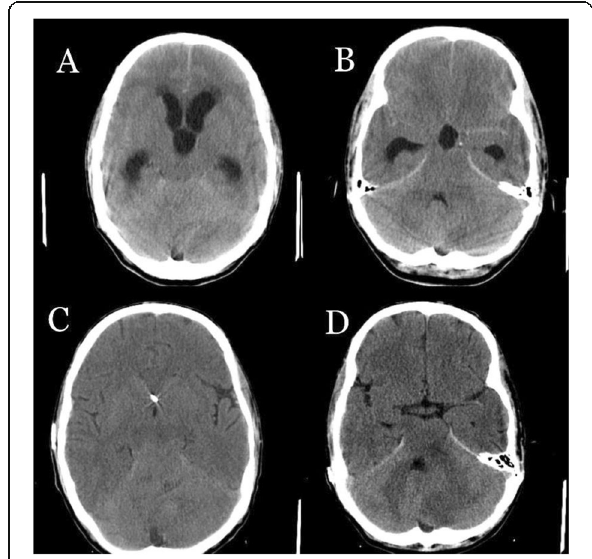
Fig. 2 a , b Initial CT scans showed a posterior cranial fossa mass obstructing the 4th ventricle. c , d The hydrocephalus was resolved with a ventriculo-peritoneal shunting